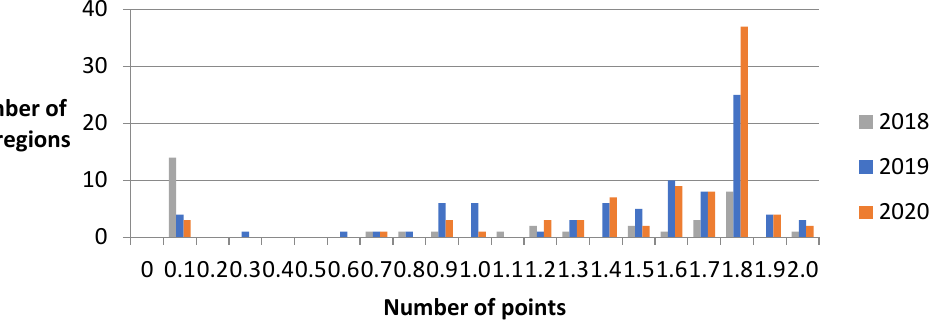
Figure 4. The total score of the satisfaction of PwD (their legal representatives) with AT.